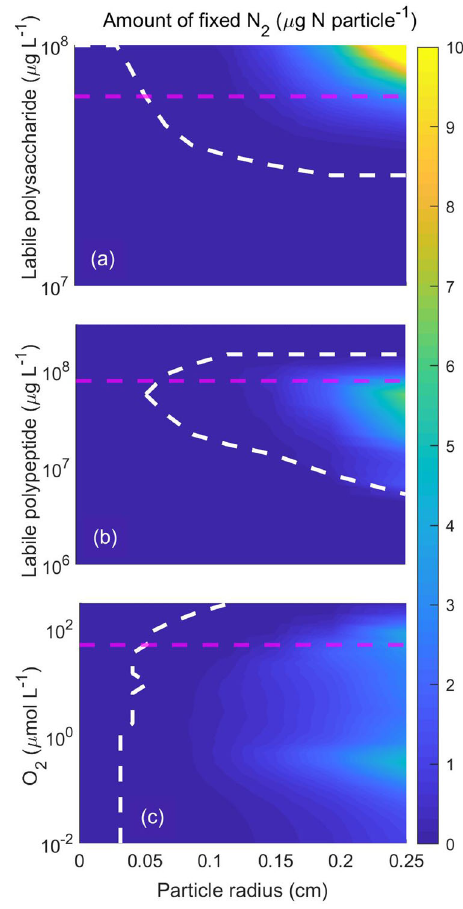
Fig. 4 Effects of particle size, O 2 , and initial polysaccharide and polypeptide concentrations on N 2 fi xation rates. The total amount of fi xed N 2 per particle as a function of particle radius and initial labile polysaccharide ( a ), initial labile polypeptide ( b ), and surrounding O 2 concentration ( c ). The white dashed line separates regions of occurrence and non-occurrence of N 2 fi xation (N (cid:1) 3 μ g N particle − 1 ). The horizontal magenta dashed lines fix > 10 indicate the base value for other plots, e.g., in ( a ), magenta dashed line represents the level of polysaccharide concentration in b and c . The chosen concentration ranges corresponds to those in natural particles 60,81